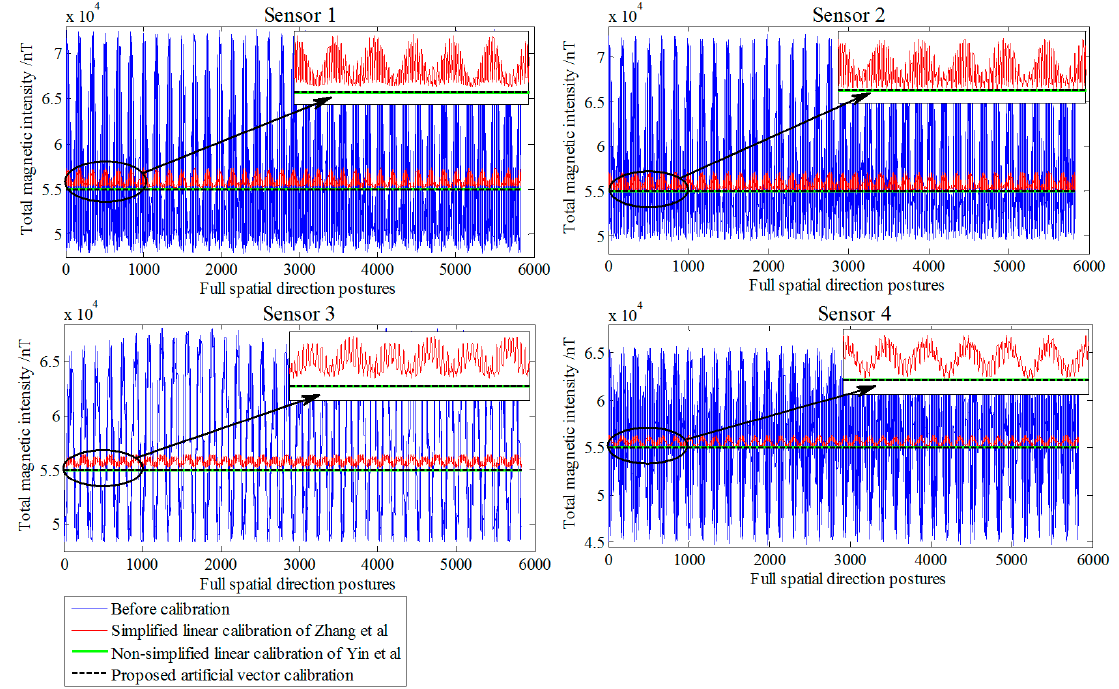
Figure 5. Comparison of total magnetic intensity (TMI) before and after calibration in the simulation. Sensors 2018 , 17 , x FOR PEER REVIEW 11 of 18